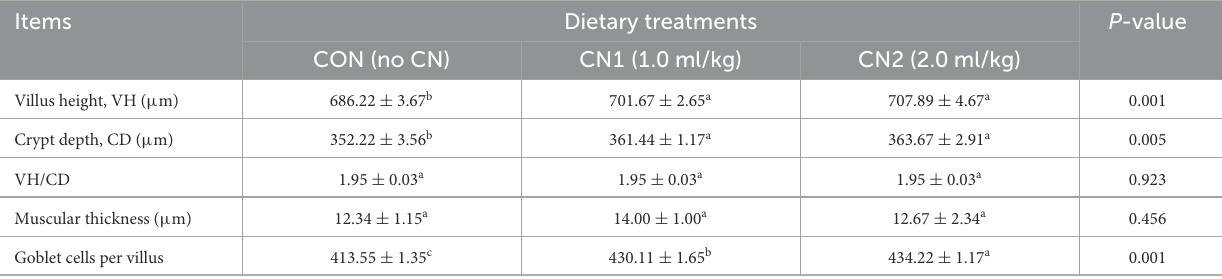
TABLE 8 Dietary curcumin nanospheres (CN) on jejunal histomorphology in finishing pigs for 40 days 1 .